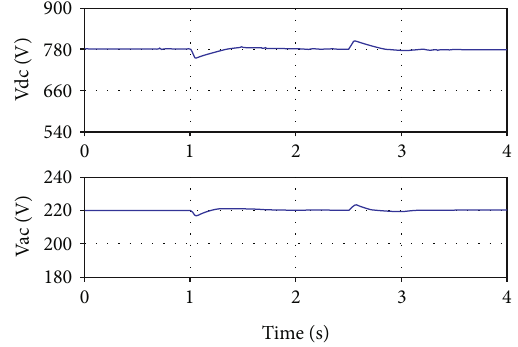
Figure 15: DC-link voltage and AC bus voltage during irradiance